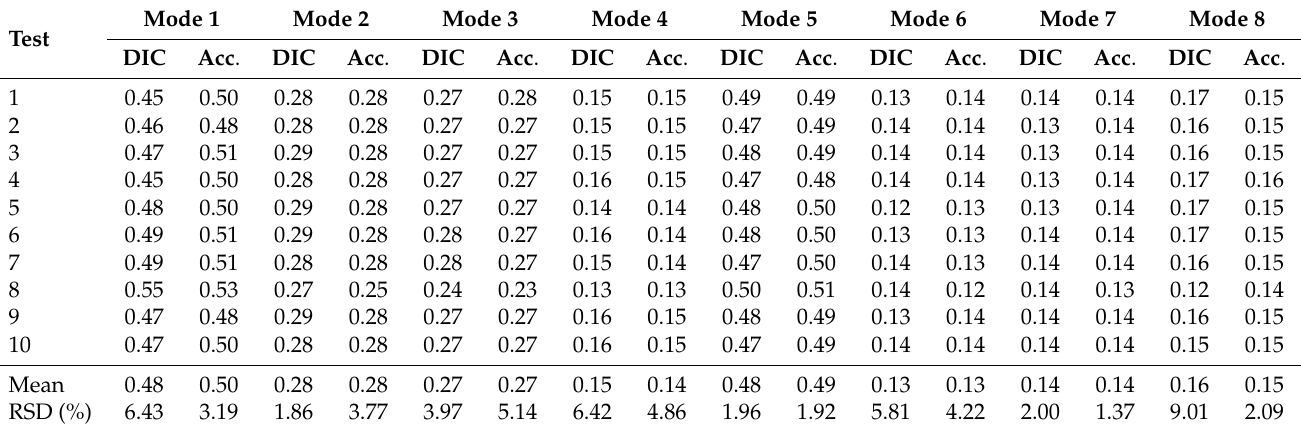
Table 5. Modal damping ratios (in %) of the first eight modes of the cantilever beam determined for different tests from DIC measurements and accelerometers.